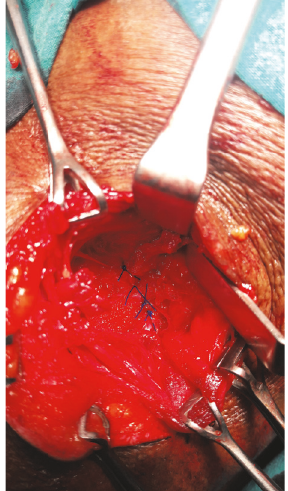
Figure 4: Fascial flaps sutured over the